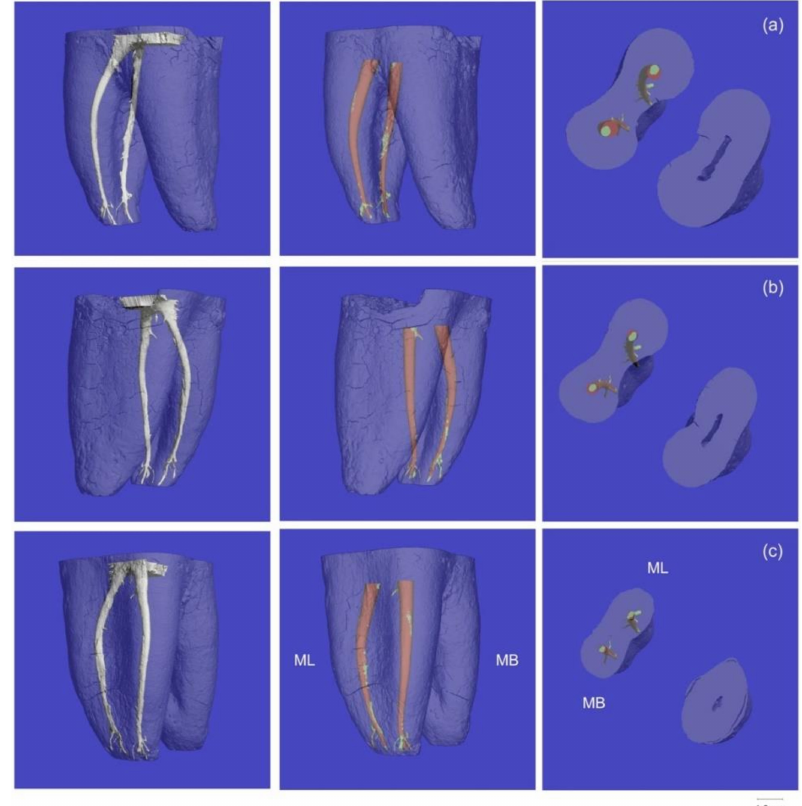
Figure 2. A representative sample of prepared root canals. The left column shows unprepared canals. The middle column shows the treated (red) and untreated (green) canal surfaces. The right column shows the canal cross-sections of the canals: ( a ) coronal, ( b ) middle, and ( c ) apical thirds. The mesiolingual (ML) canal was instrumented with One Curve (OC), and the mesiobuccal (MB) canal was instrumented with One Shape